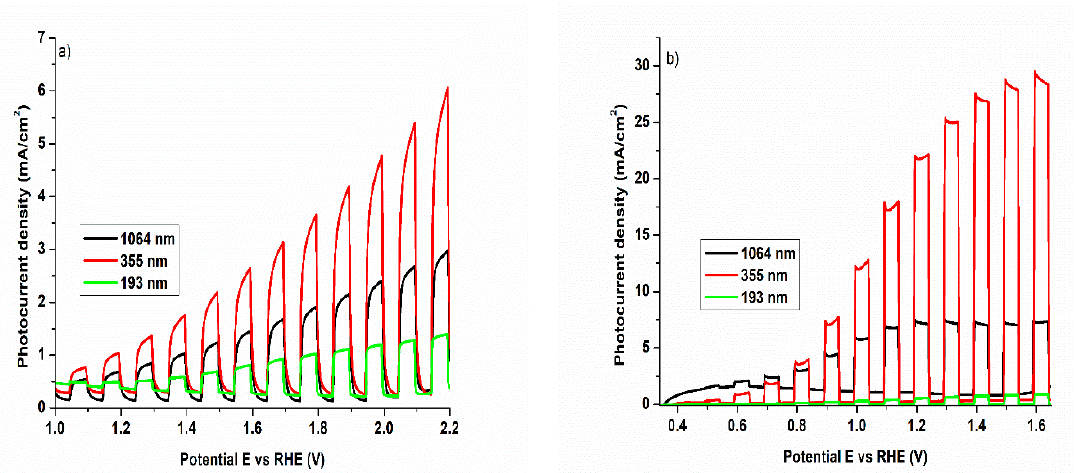
Figure 5. Potentiodynamic measurements under chopped irradiation on WO 3 /PtSi thin films manufactured at different laser wavelengths in ( a ) alkaline electrolyte: NaOH and ( b ) acidic electrolyte: H 2 SO 4.